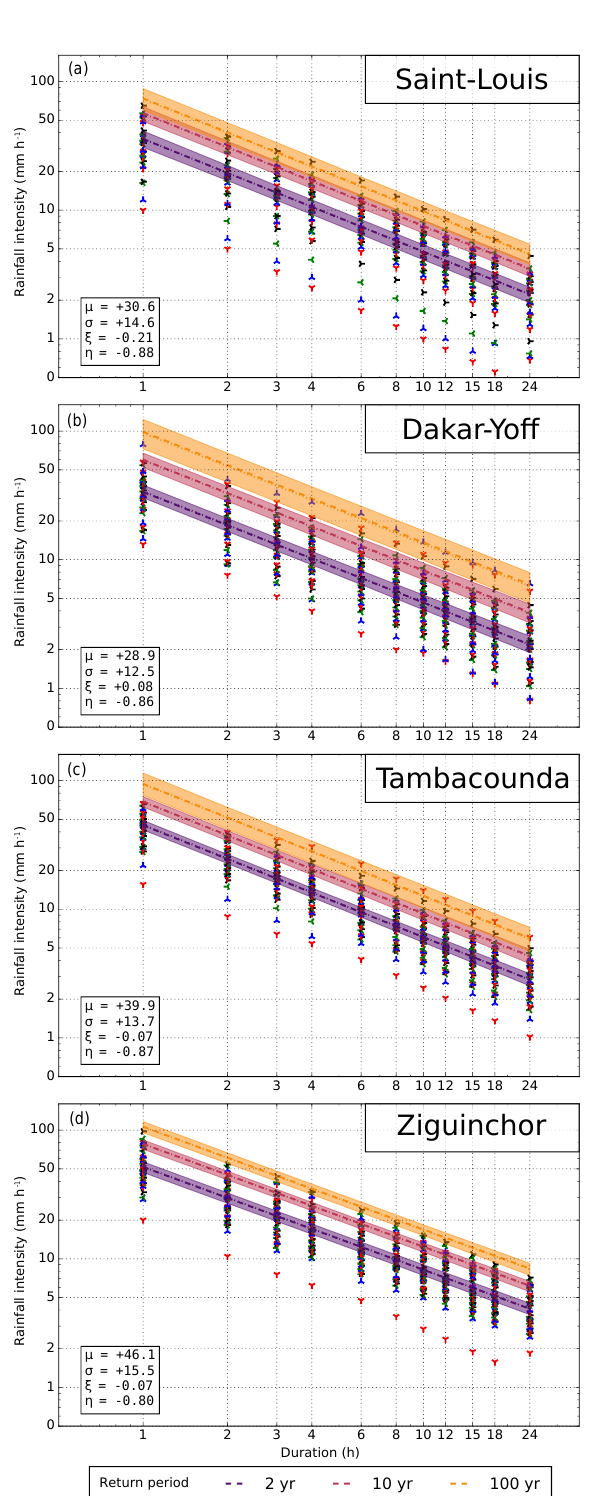
Figure 7. IDF SiSca return level plots obtained at four emblem- atic stations over Senegal ( a–d : Saint-Louis, Dakar, Tambacounda, and Ziguinchor). Shaded area represents the 90% confidence inter- val. The markers represent the observed annual maxima intensities i(D)